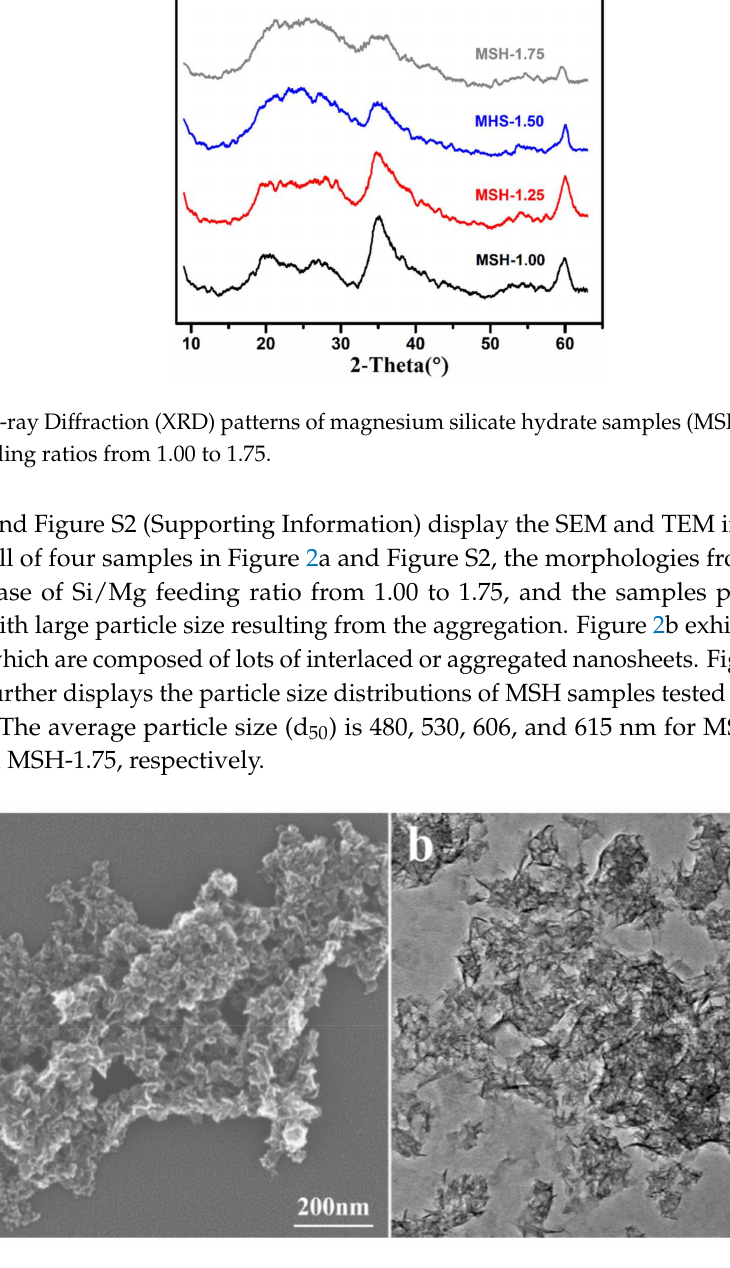
Figure 2. ( a ) Scanning electron microscope (SEM) and ( b ) Transmission electron microscope (TEM) images of MSH-1.75